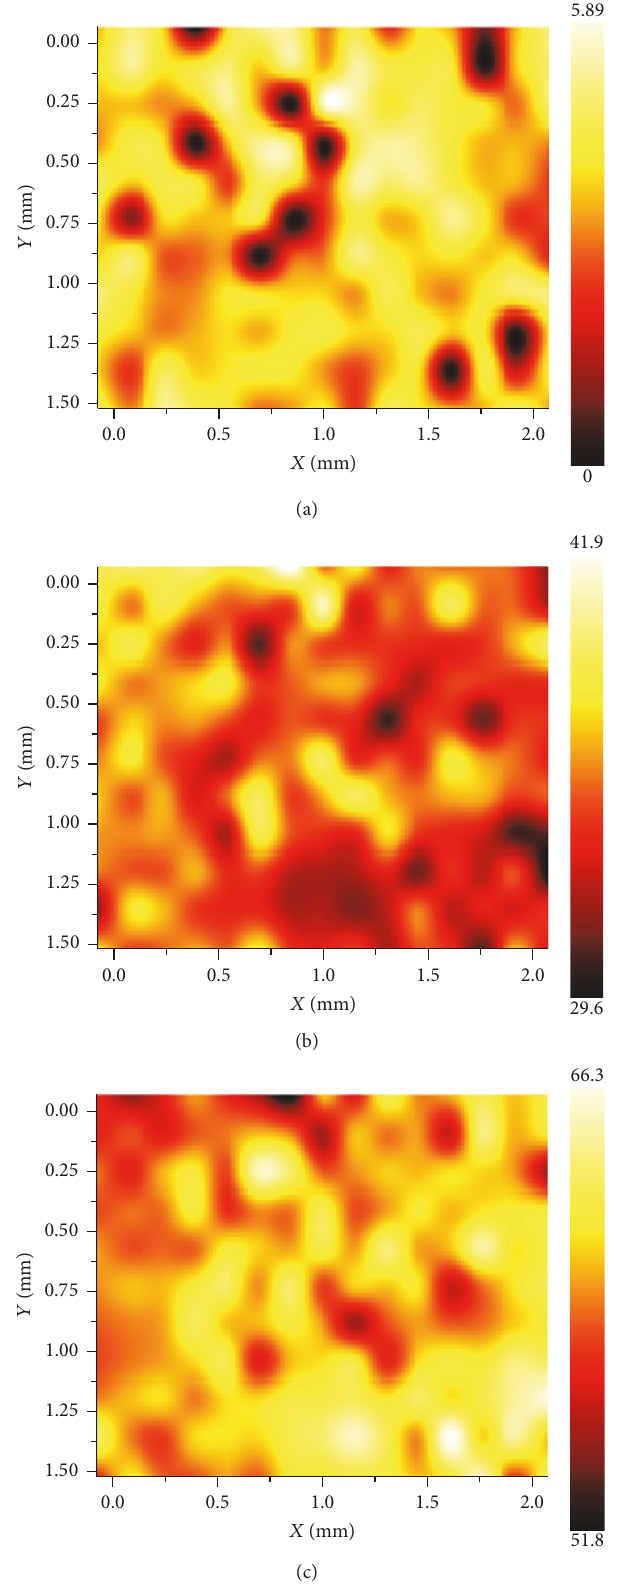
Figure 18: XPS maps for the atomic percentages of (a) Al2p; (b) O1s; and (c) Mg1s for the AZ91D alloy immersed for 40 h in 3.5 wt.% NaCl solution at room